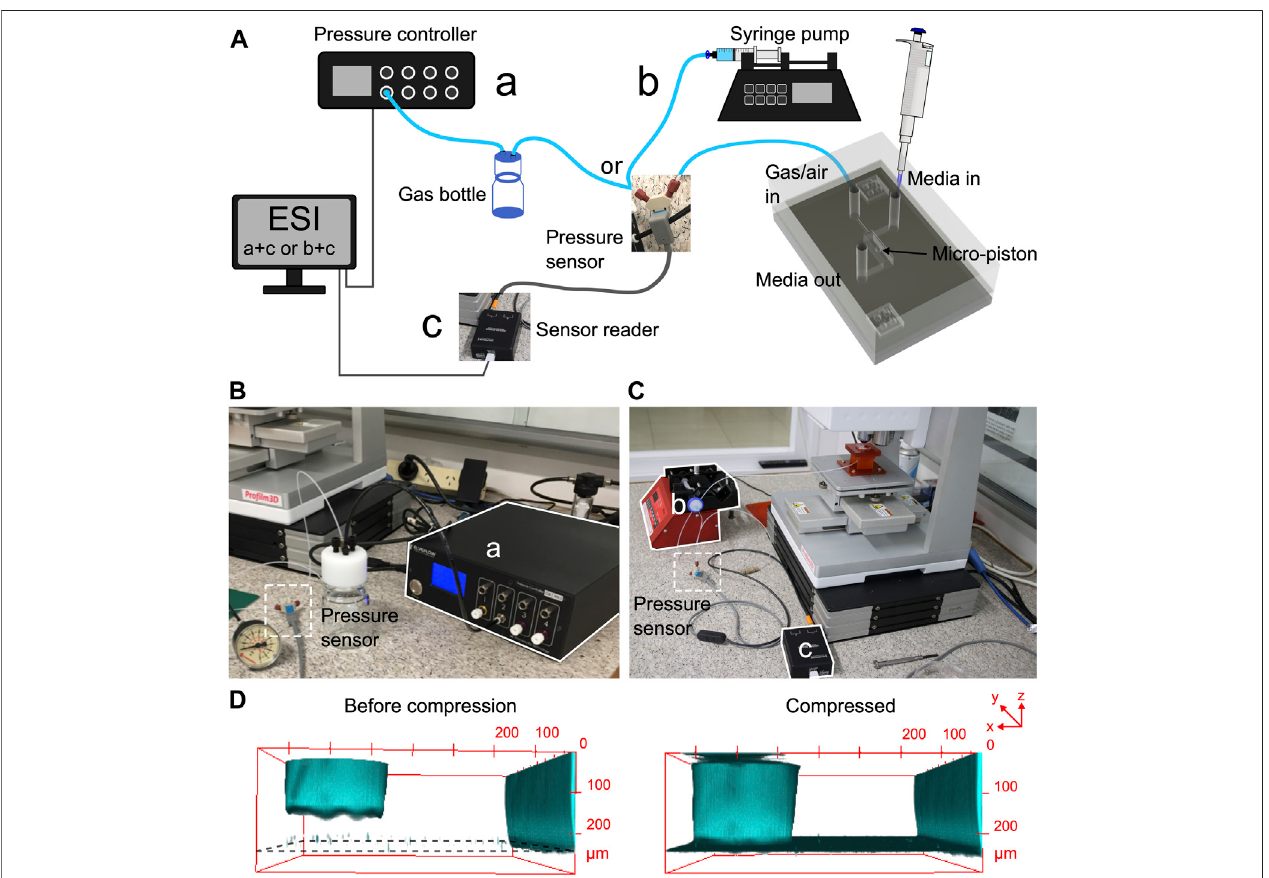
FIGURE 2 | Pressure supply, sensing setup, and confocal imaging of the micro-piston device compression. (A) Schematic of the experimental setup showing the waysofpressuresupplyintothecontrolchannelandcellseeding.Cellswithinmediawereintroducedintothecellchannelthroughtheinletlabeledas “ mediain, ” andgas or air pressure was supplied through the inlet of the control channel labeled as “ gas/air in. ” The pressure sensor was located just before the gas fl ow into the control channel. (B) Experimental setup with the pressure controller system. (C) Experimental setup with the syringe pumping system. (D) Confocal images illustrating the concept of applying compression with an integrated PDMS micro-piston in a micro fl uidic channel. PDMS was stained with DiD for